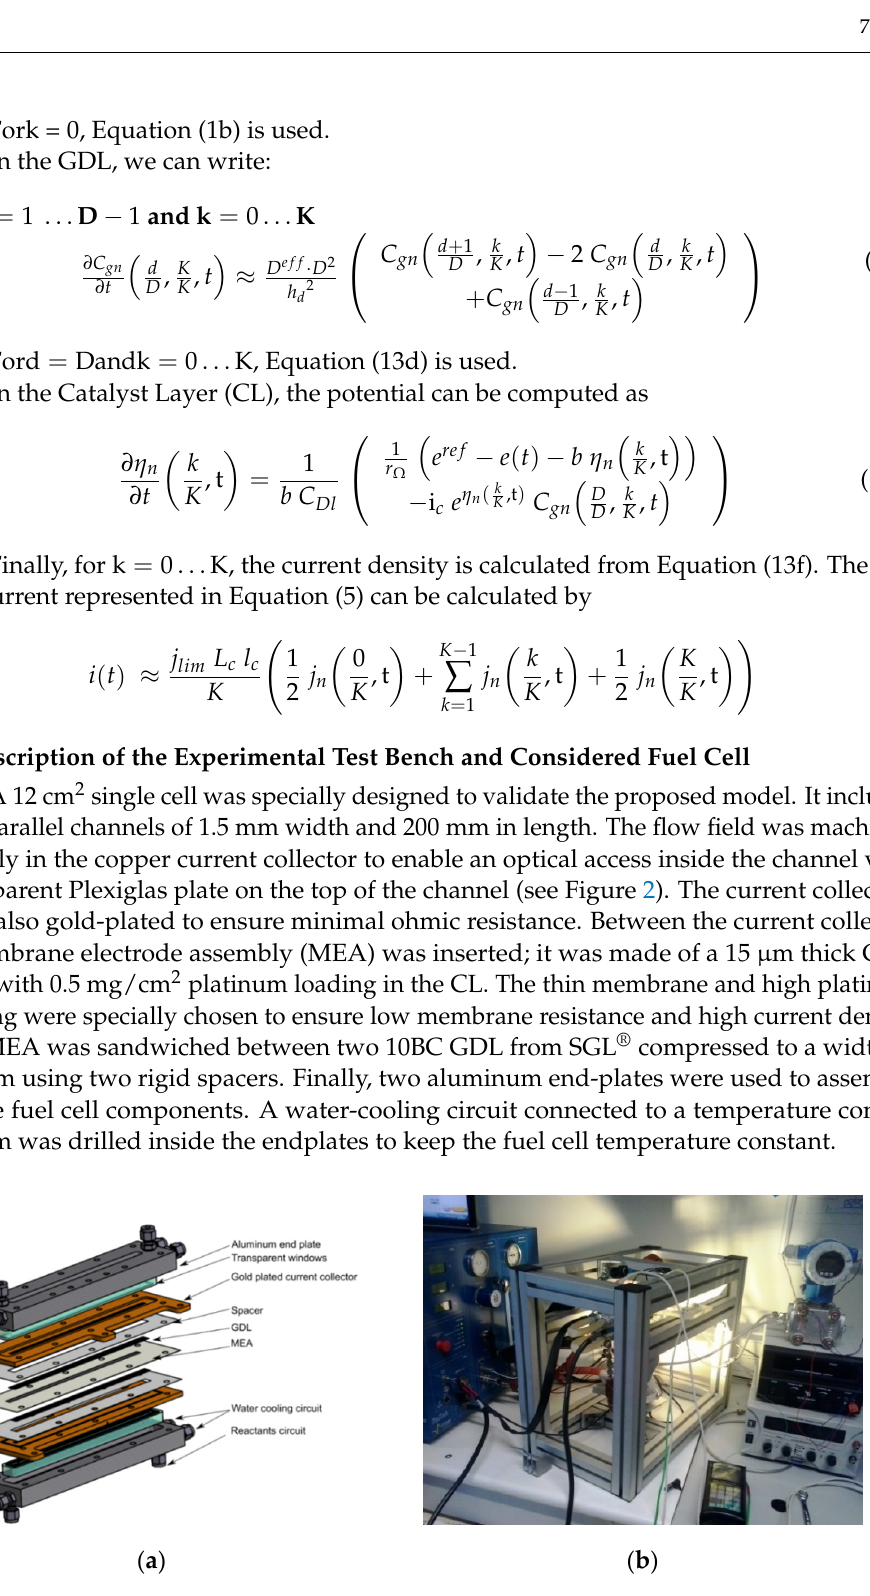
Figure 2. ( a ) Three-dimensional view of the straight channel fuel cell reprinted from [32]. ( b ) Fuel cell benchmark setup in LTeN, Nantes.